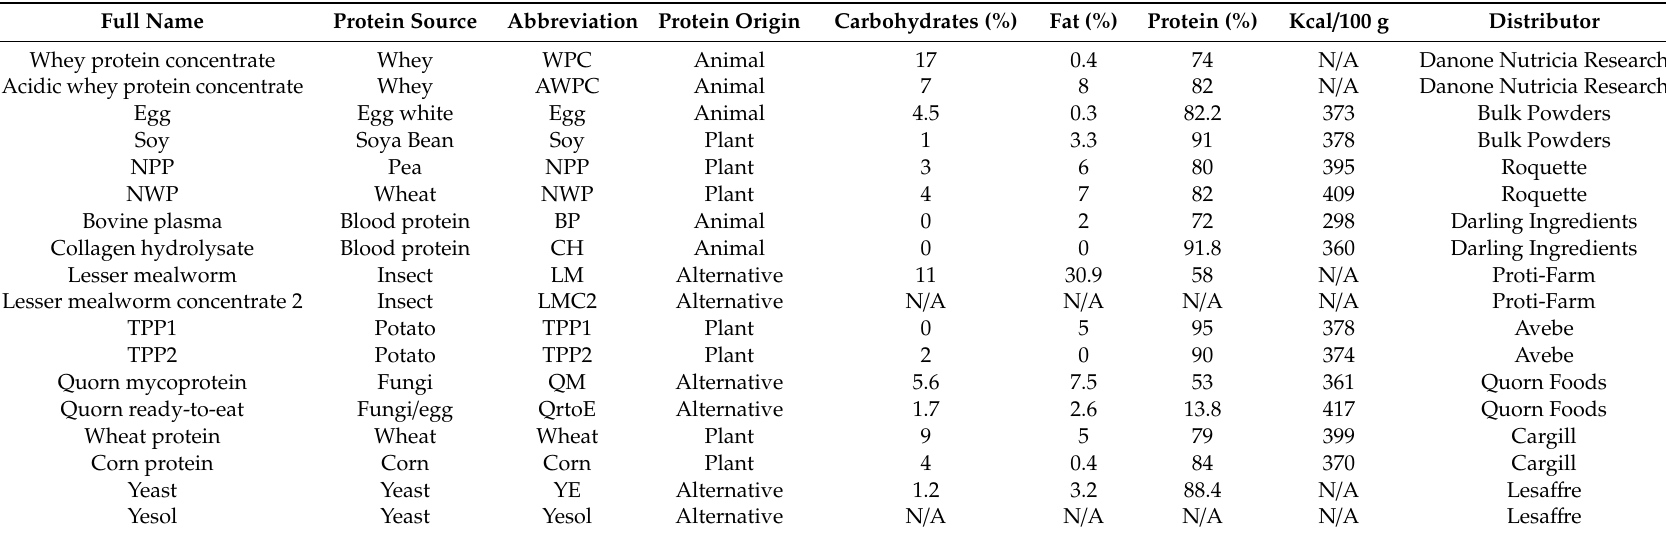
Table 1. Overview of the 18 dietary proteins evaluated, including their characteristics and